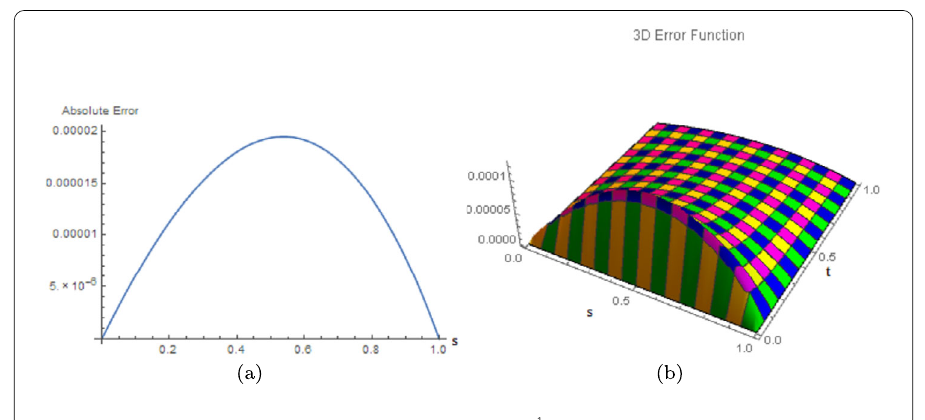
Figure 9 The exact (left) and numerical (right) solutions for Example 3 when τ = 0.01, h = 1